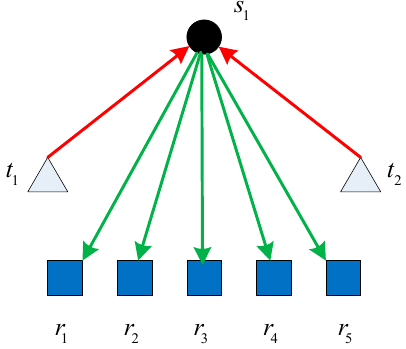
Figure A1. An example of a special network topology diagram.